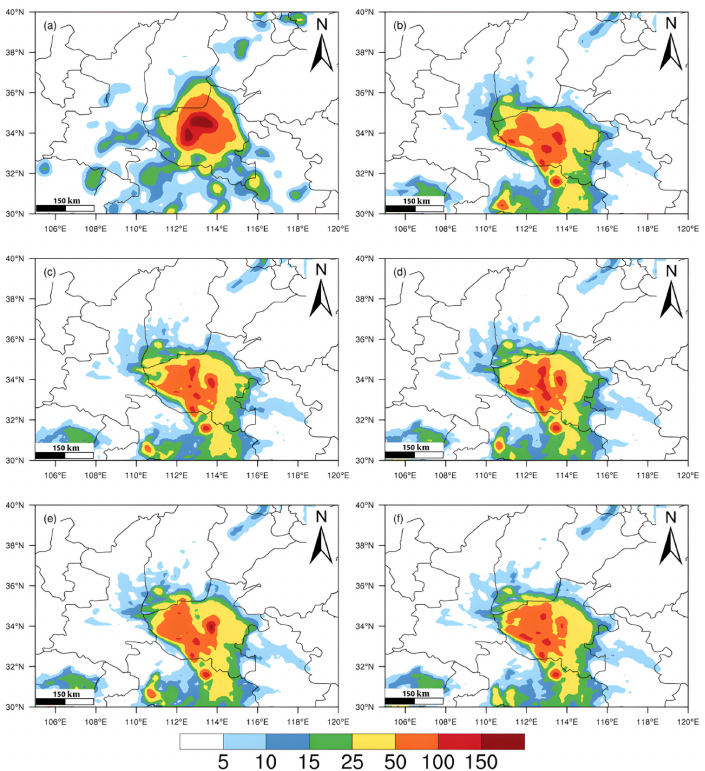
Figure 7. The 24 h cumulative rainfall (unit: mm) from 00:00 to 23:00 on July 19 with a model start time of 00:00 on the 19th: ( a ) measured rainfall, ( b ) exp0, ( c ) exp1, ( d ) exp2, ( e ) exp3, and ( f ) exp4.